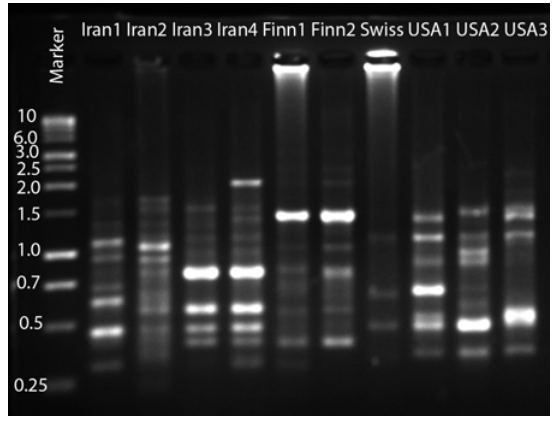
Figure 2. The bands produced by ISSR primer14 for 10 Strains of H. pluvialis.